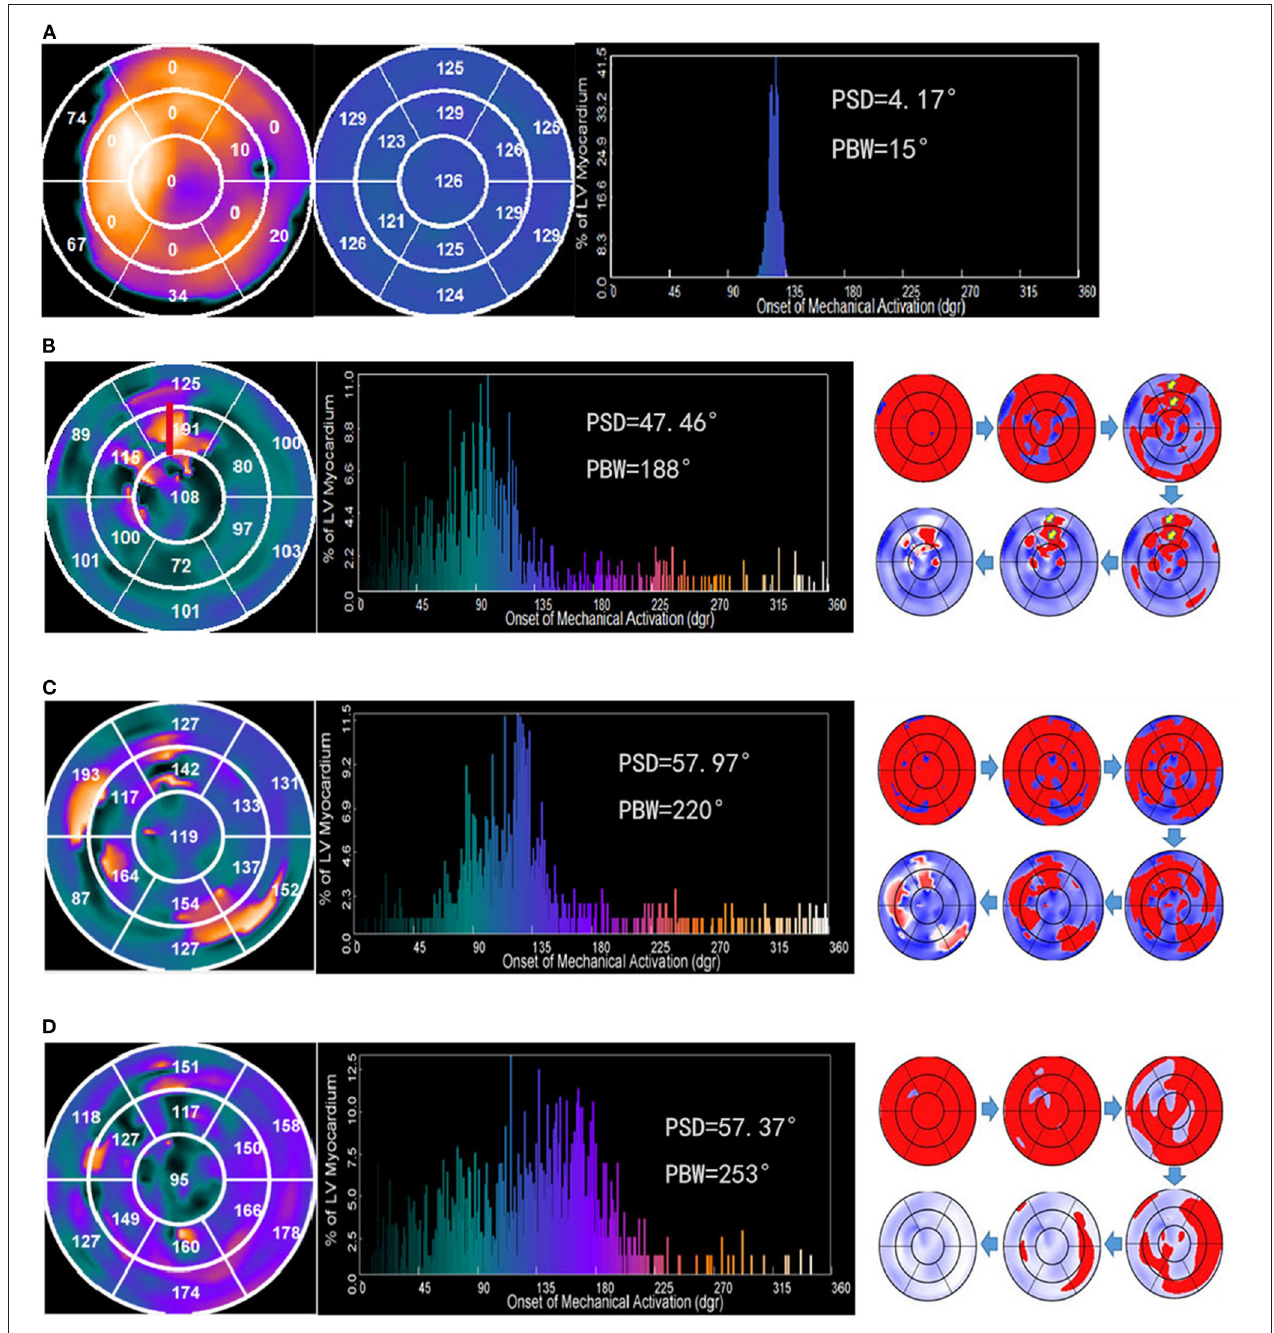
FIGURE 1 | Examples illustrating four contraction patterns. Numbers in the regional contraction polar maps represents the mean phase angle in each segment. The big number or bright color represents the late contracting segments. (A) Polar map of regional myocardial viability (left). The bright color represents the viable myocardium. The perfusion with < 50% of the maximum tracer uptake was defined as scar. The number indicates the percentage of scar in this segment. A patient with the mild dyssynchronous contraction pattern who had a super-response to CRT (middle). (B) A patient with the U-shaped contraction pattern who had a super-response to CRT. A line of block was apparent between the septum and lateral wall. The anterior wall was the latest contraction site (red). (C) A patient with the heterogeneous contraction pattern who did not have a super-response to CRT. The phase angles of each segment are incommensurable, which caused multiple sites with the significant contraction delays. (D) A patient with the homogeneous pattern who did not have a super-response to CRT. The propagation proceeded from the septum to lateral wall homogenously.